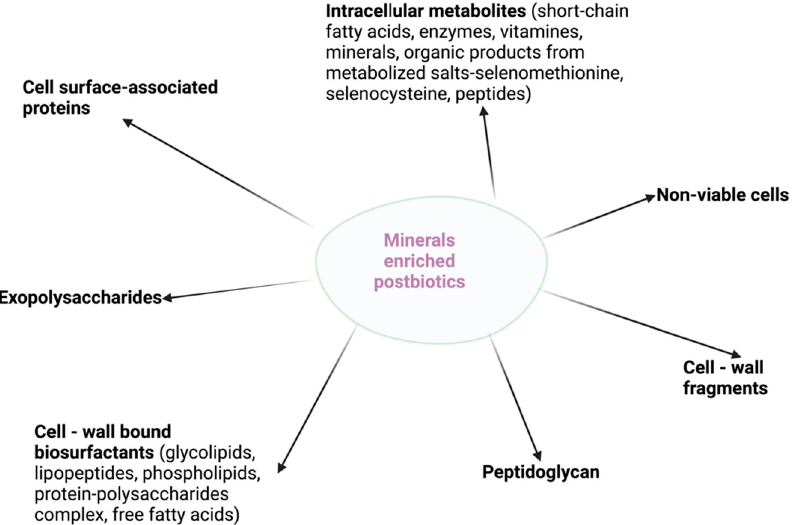
Figure 1. Molecules produced by mineral-enriched postbiotics.